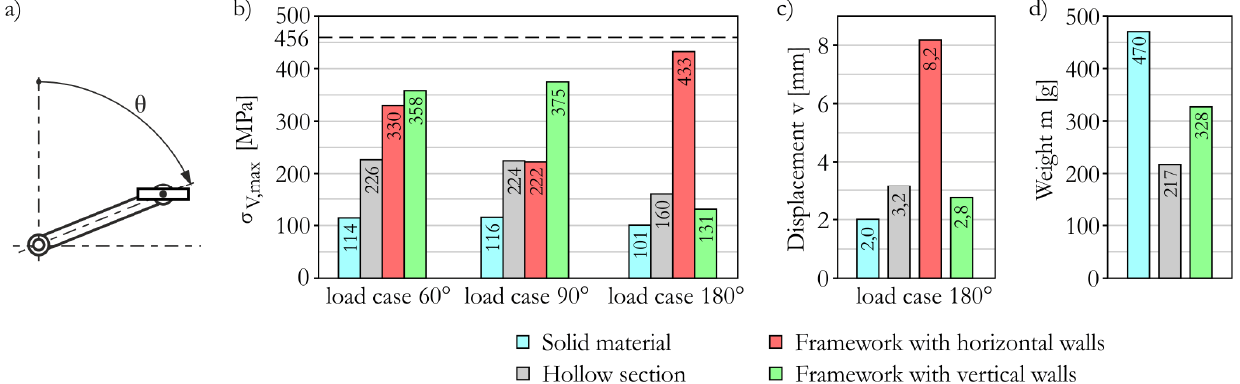
Figure 9: Numerical stress analysis results for different load cases b) resulting from various bicycle crank angles a) and maximum displacement results c). Data for the mass are presented in d).